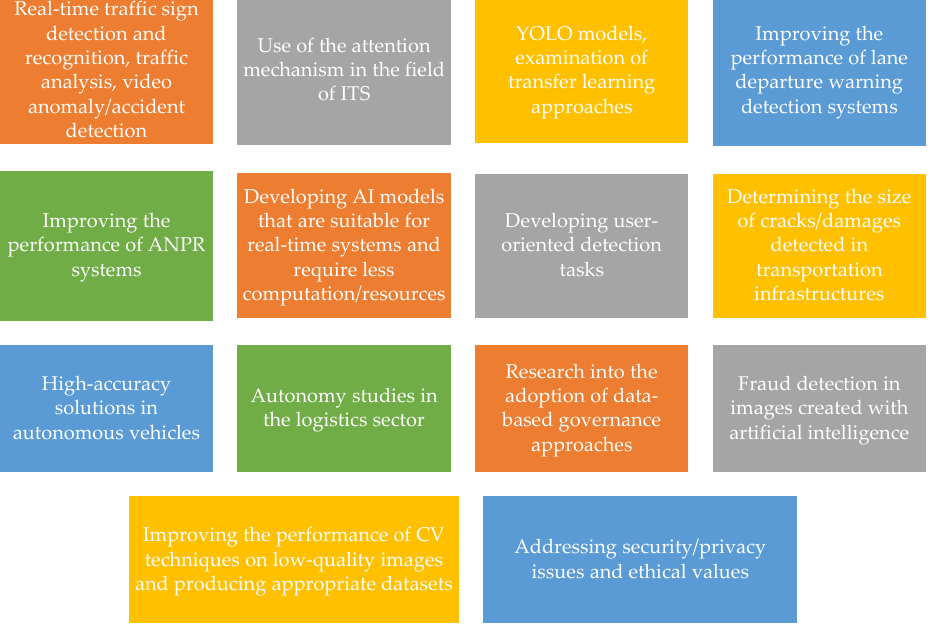
Figure 6. Future Research Areas and Trends .